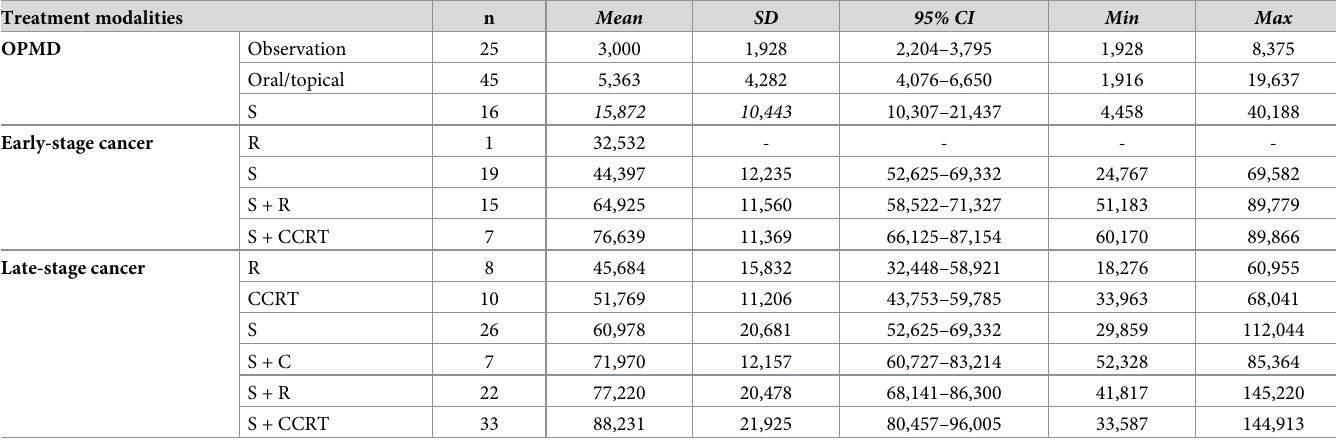
Table 3. Total cost per patient, stratified by treatment modalities (in